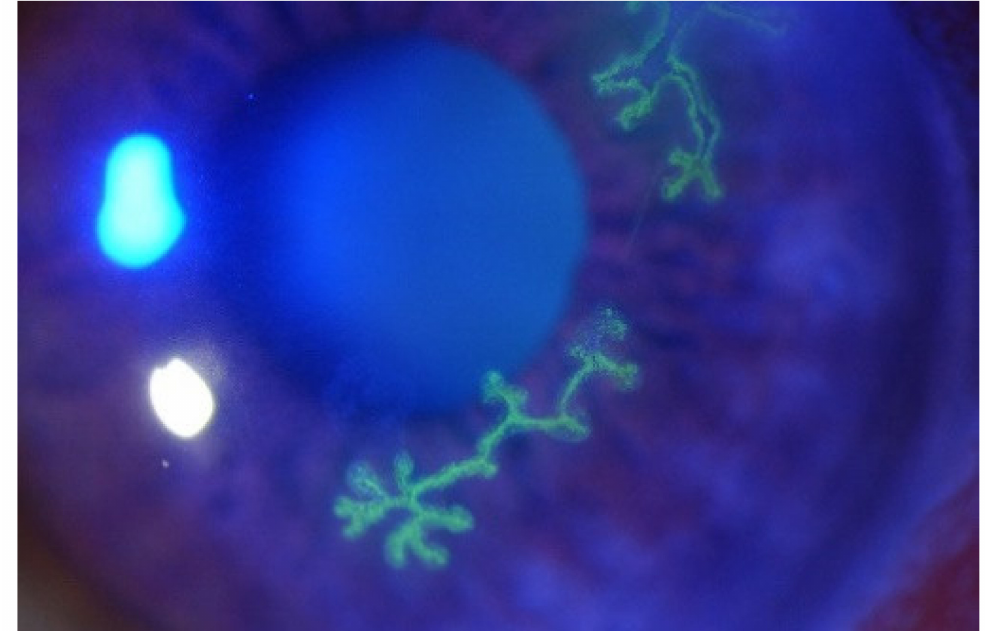
Figure 1. The image shows dendritic lesions caused by ocular HSV infection. The branches of the lesions can be clearly seen, as they have been fluorescently